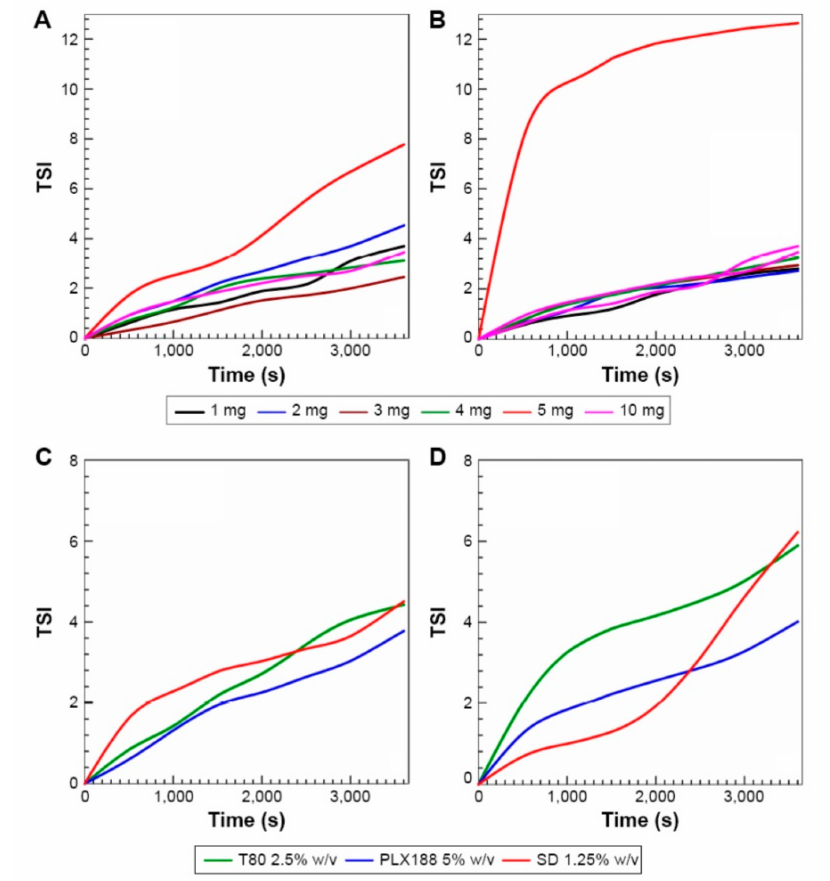
Figure 5. Effect of varying zein concentrations ( A , B ) and surfactants ( C , D ) on the formation condi- tions and Turbiscan Stability Index of zein nanoparticles. T 80 is Tween 80, PLX is Poloxamer 188, and SD is sodium deoxycholate monohydrate. Reprinted with permission from ref. [55]. Copyright 2018 Dove